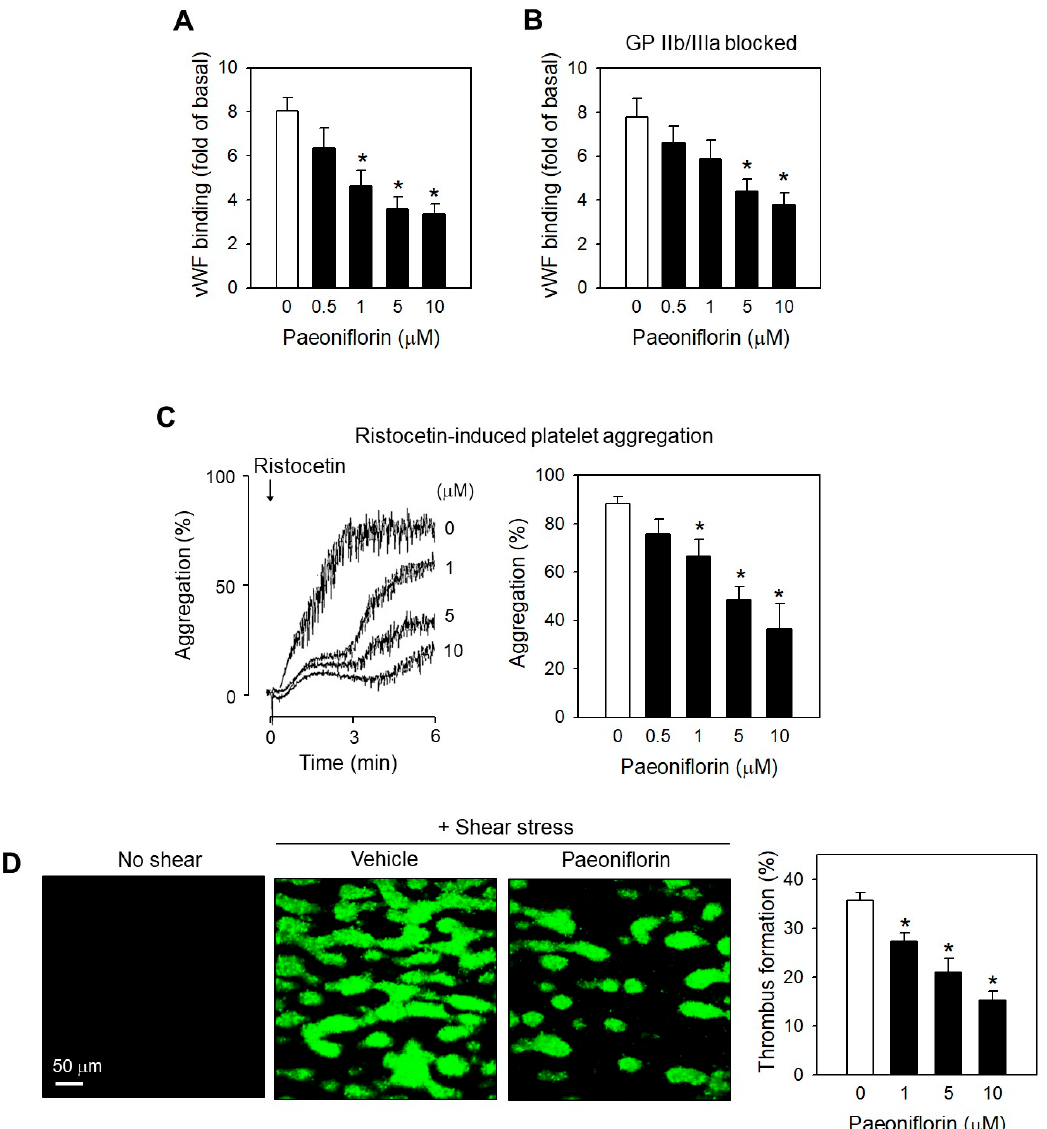
Figure 4. Effects of paeoniflorin on SIPA depending GPIb-vWF interaction. ( A , B ) Effects of paeoniflorin on vWF binding to platelets under high shear stress was determined by flow cytometry, in the absence ( n = 4) ( A ) and in the presence of GPIIb/IIIa blocker ( n = 4) ( B ). Arg-Gly-Asp (2 mM) was used to block GPIIb/IIIa by pre-incubated with platelets. C , Effects of paeoniflorin on ristocetin-induced platelet aggregation in human PRP ( n = 4). ( D ) Effects of paeoniflorin on platelet adhesion on collagen (100 µg/mL) coated surface under shear stress (1,500 s -1 for 5 min) in flow chamber ( n = 3). The platelet adhesion was observed by confocal microscopy LSM-710 and the coverage area was analyzed by ImageJ. Values are mean ± SEM (expressed as the error bar) of the independent experiments from different blood donors. *, significant differences from control group ( p < 0.05). Scale bar ( D ): 50 µm. Green: Calcein-loaded platelets.